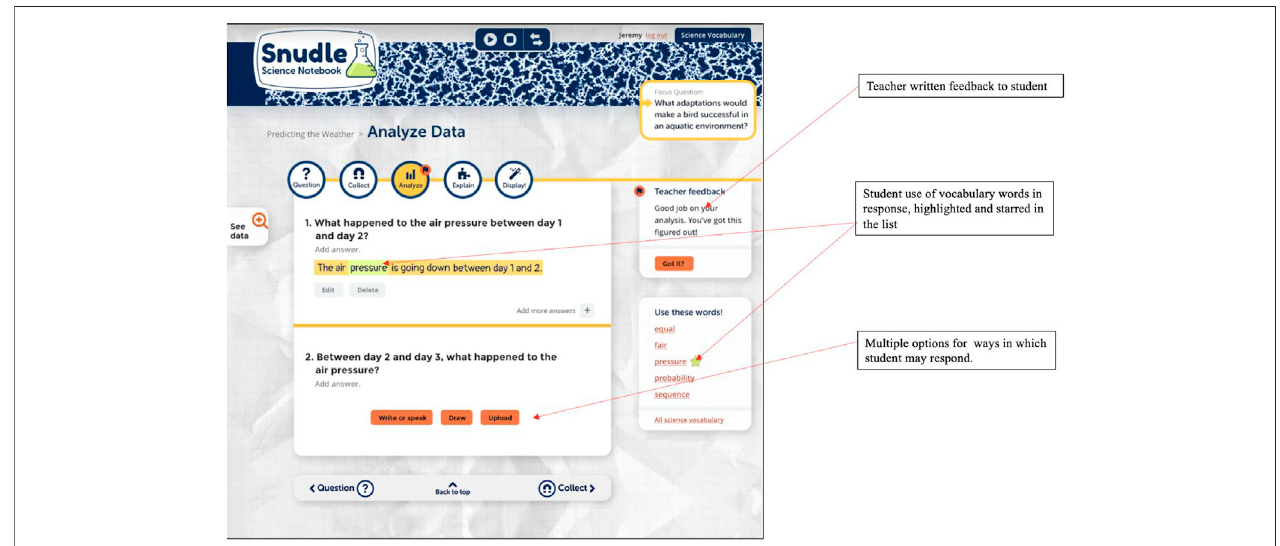
FIGURE 2 | Screenshot of the Analyze page in SNUDLE in which students see the focus question and have access to their data. When responding to questions, users have several options for how to respond including writing, speaking, drawing or uploading.